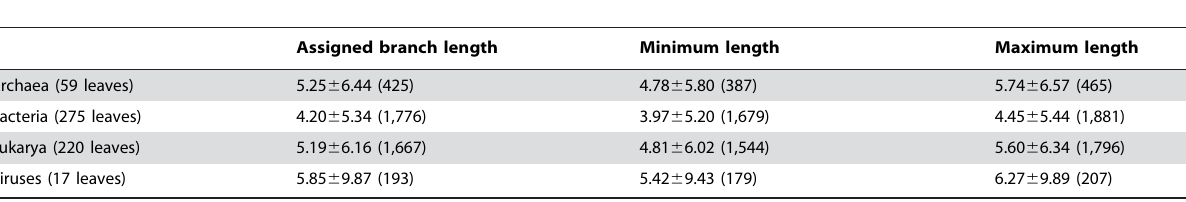
Table 4. Rates of evolution in the three superkingdoms and viruses derived from strict consensus trees